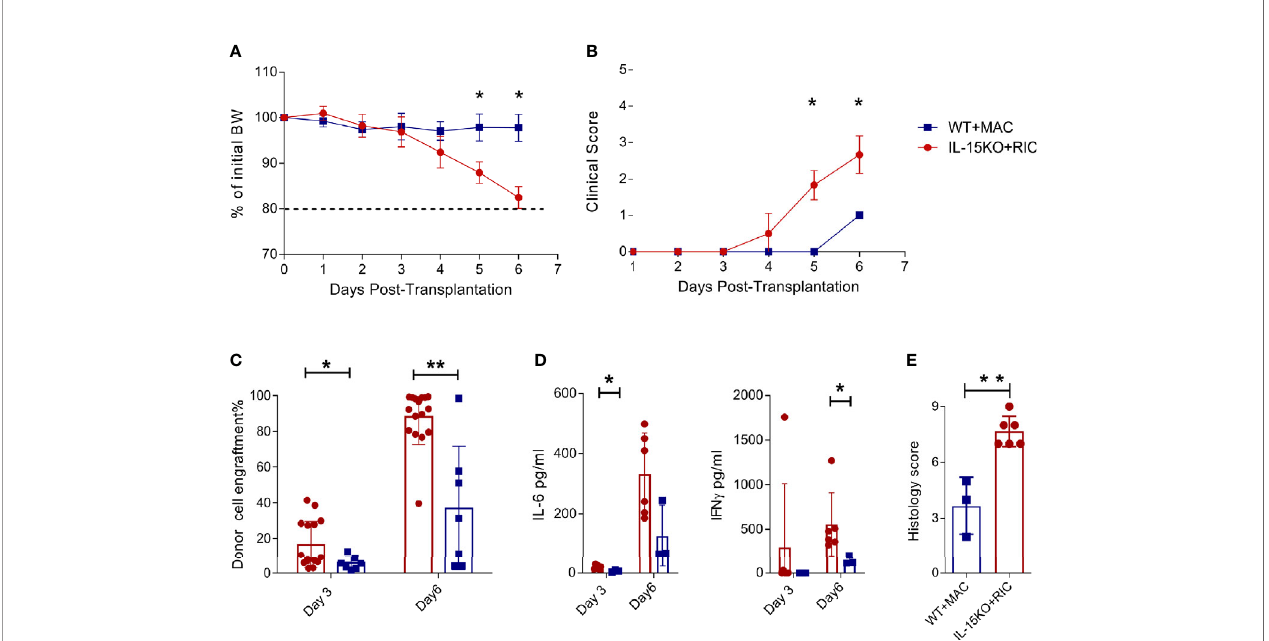
FIGURE 1 | IL-15 KO + RIC alloSCT recipients develop hyperacute GVHD. C57BL/6 WT mice were irradiated with MAC, and IL-15 KO mice were irradiated with RIC, followed by alloSCT. Mice were monitored daily for (A) body weight and (B) clinical scores, and (C) donor cell engraftment and (D) plasma cytokine concentrations of IL-6 and IFN g on days 3 and 6. (E) Mice were killed on day 6 post-alloSCT, and GVHD histology was conducted on gut tissue. Statistical analysis was performed using Mann-Whitney unpaired T test. *p < 0.05, **p <